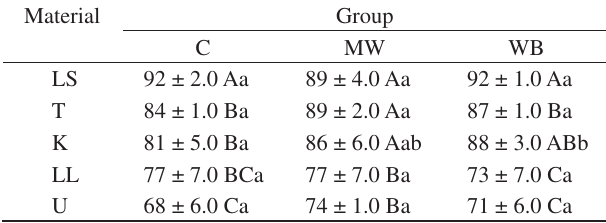
Table 2. Degree of conversion (%) expressed as mean values with standard deviations and results of statistical analysis.